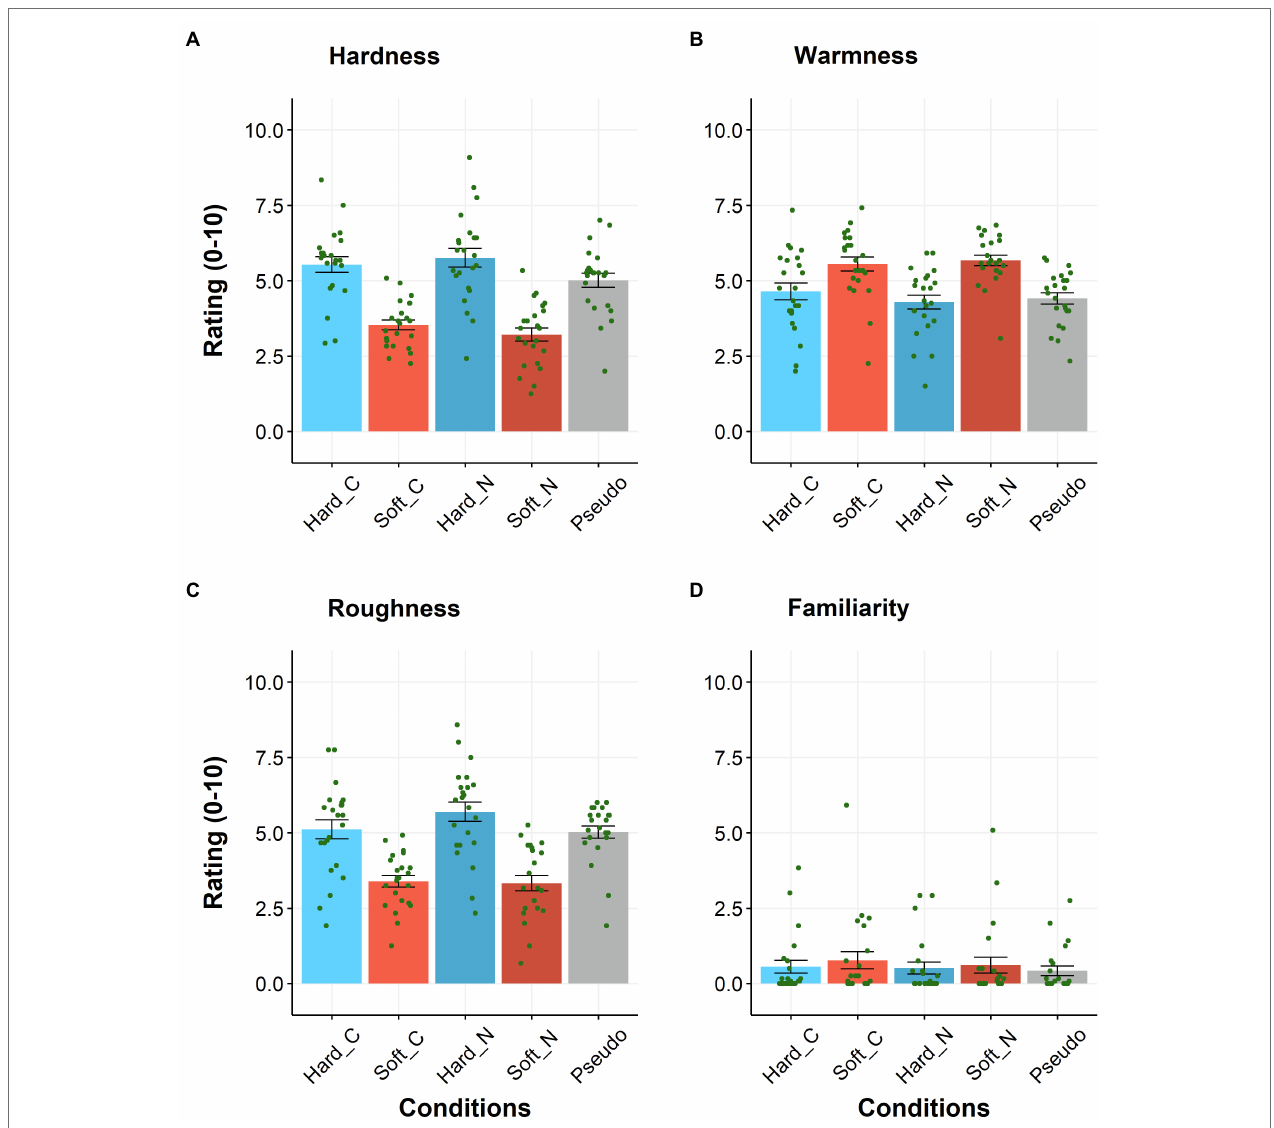
FIGURE 3 | US subjects’ ratings for hardness (A) , warmness (B) , roughness (C) , and familiarity (D) . Hard_C, Soft_C, Hard_N, Soft_N, and Pseudo indicate conventional “hard,” conventional “soft,” novel “hard,” and novel “soft” words, as well as non-sound-symbolic pseudowords, respectively. N = 23. Error bars indicate SEM, and each dot indicates each subject’s